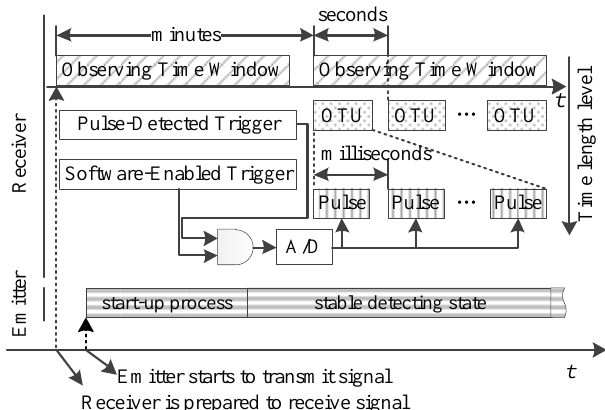
Figure 1. The schematic timing diagram of a receiver and an emitter. OTU, observing time unit; A/D, analog/digital.